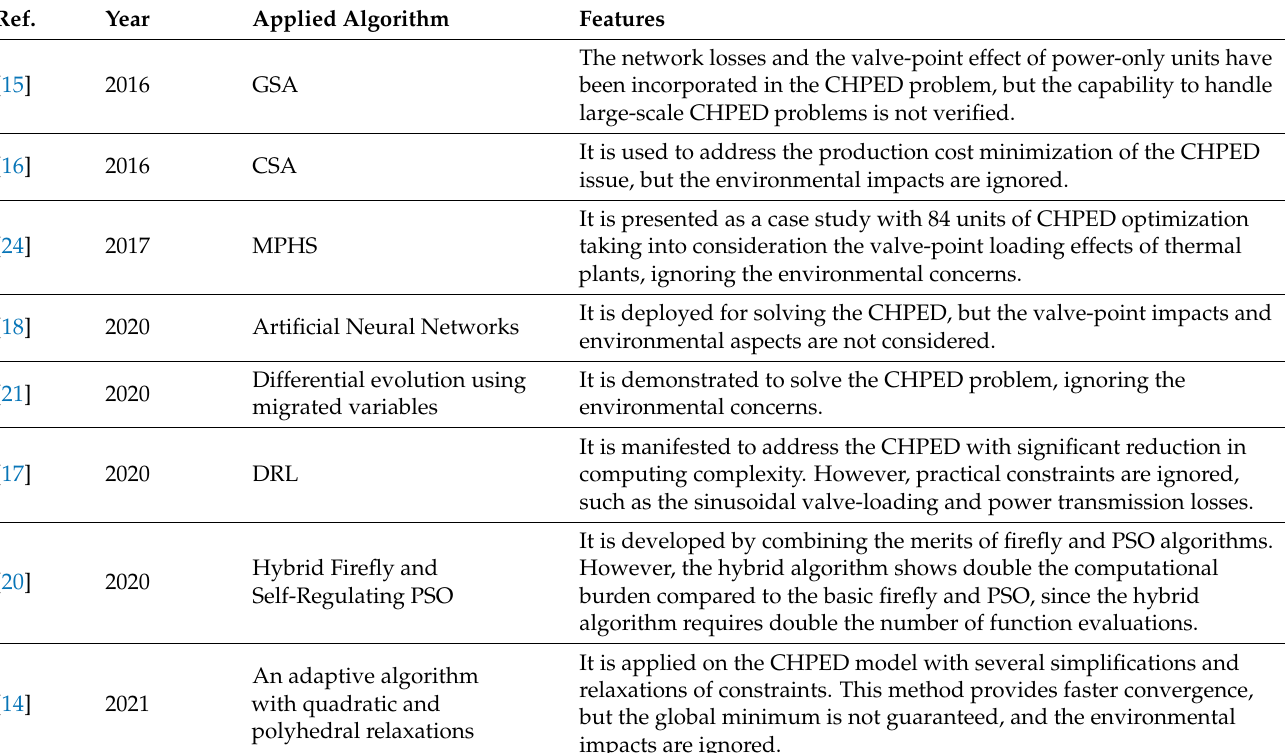
Table 1. Various algorithm strategies for CHPED and CHPEED